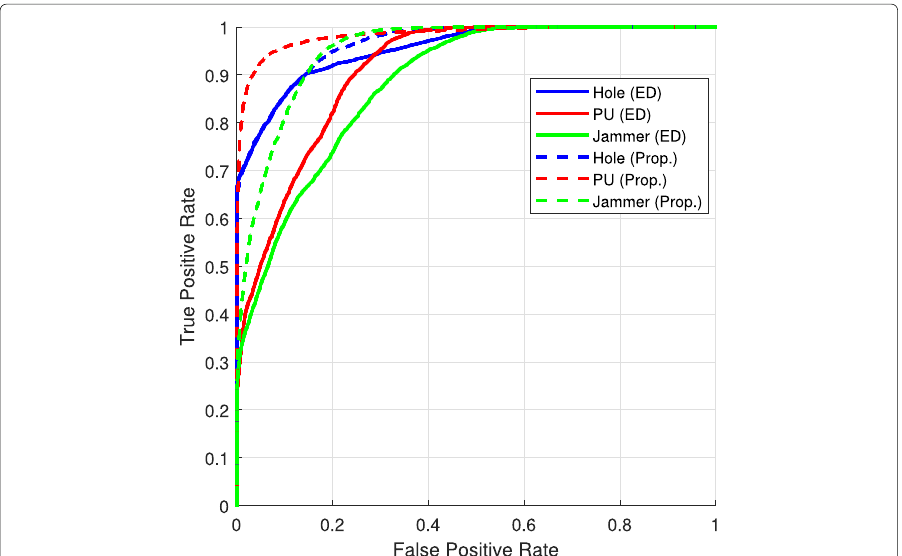
Fig. 5 Comparison of the proposed algorithm with the ED-based ML algorithm for jamming attack detection using ROC